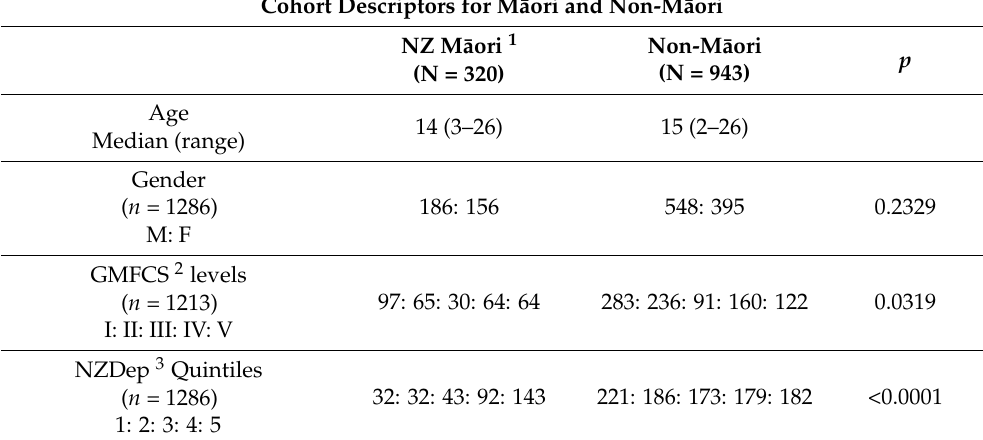
Table 2. Comparisons of M¯aori and non-M¯aori children and young adults with CP by age, gender, GMFCS, and NZDep